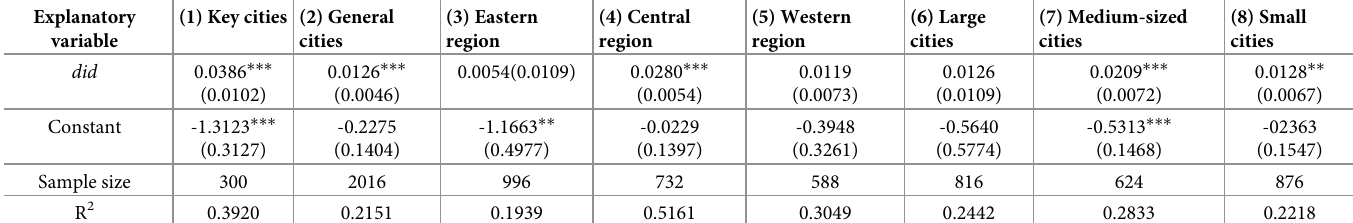
Table 6. Difference